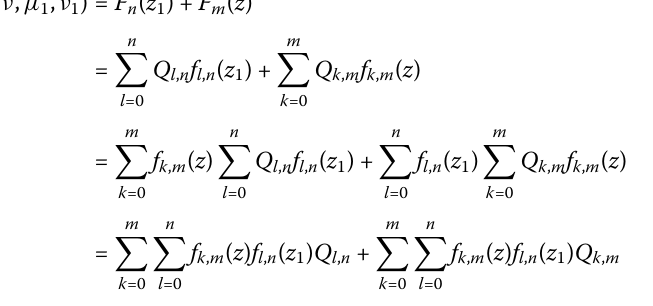
Proof From the definition of GBT-Bézier swept surface, and substituting equation